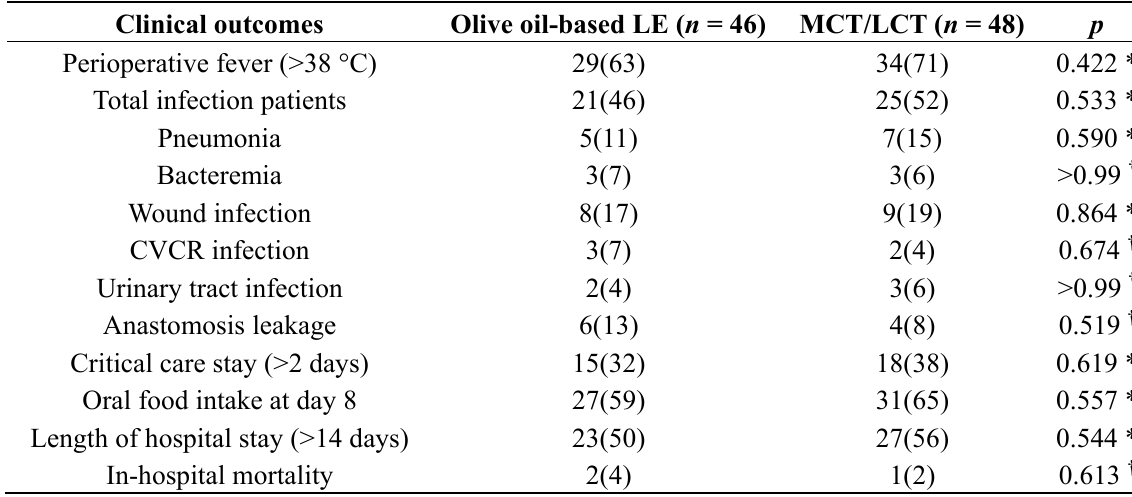
Table 3. Clinical outcomes in patients treated with PN containing olive oil-based LE or MCT/LCT, n (%).